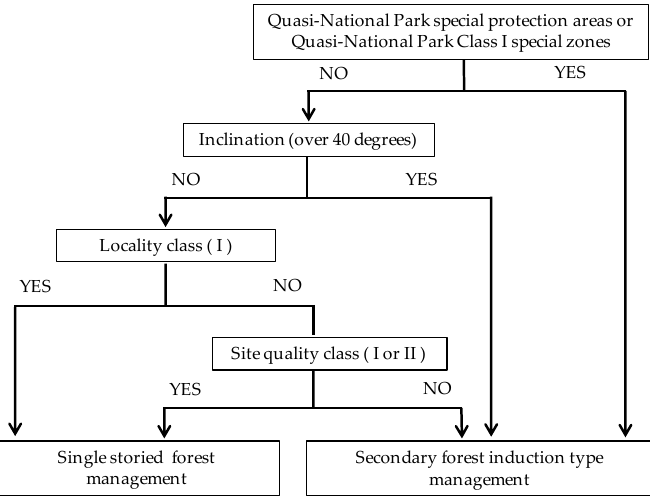
Figure 4. High impact forestry plan focusing on locality (Plan 2).